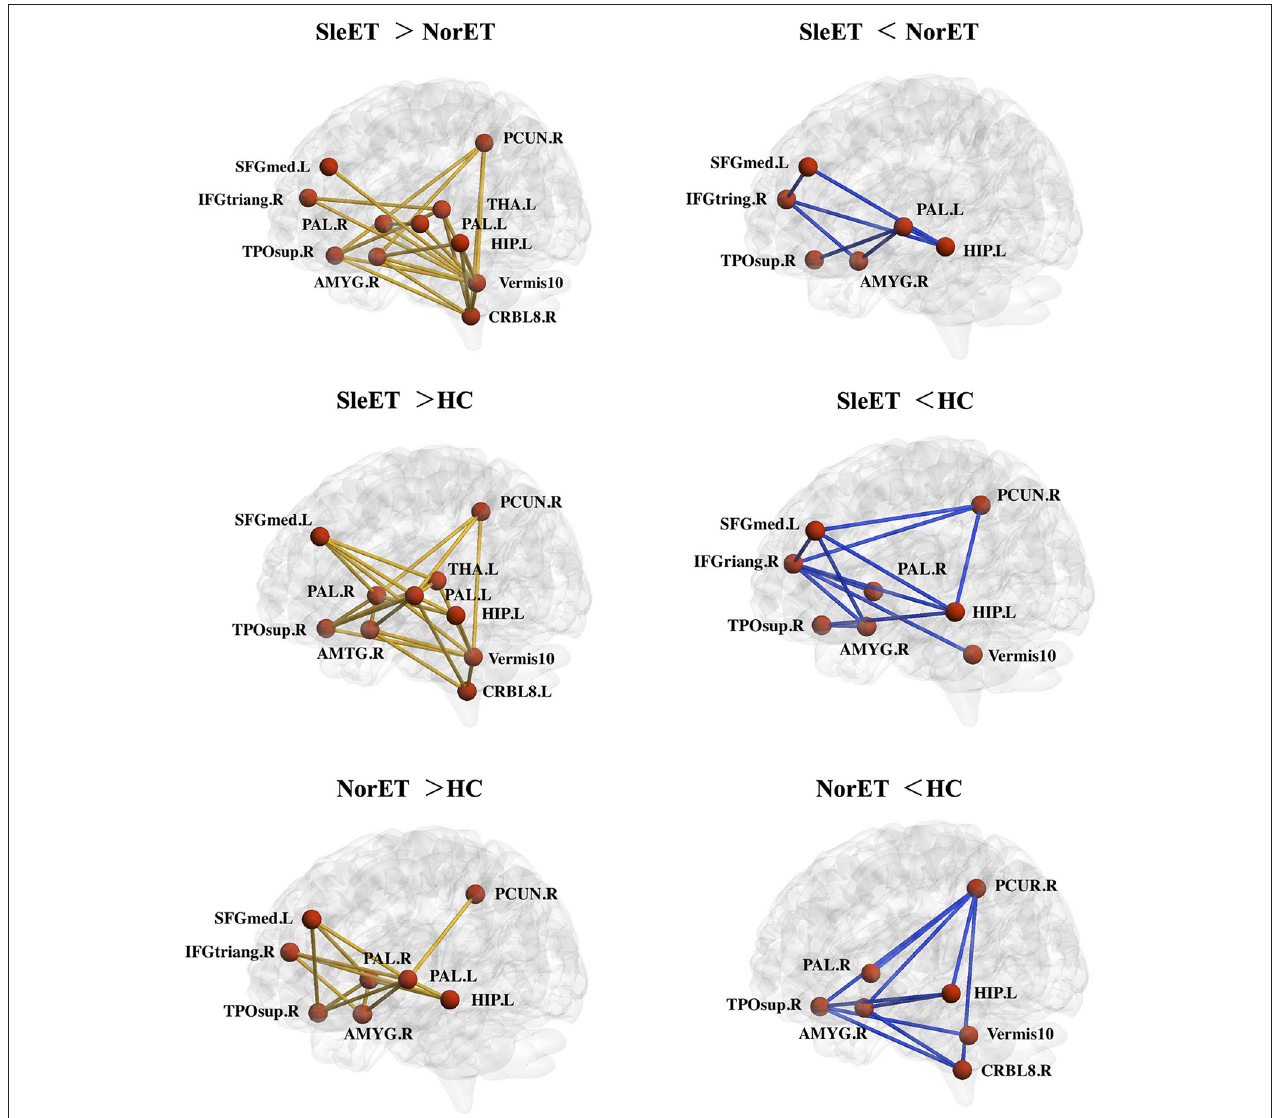
FIGURE 3 | Networks showing altered morphological connections compared among the SleET, NorET, and HC groups. Red nodes denote brain regions, and lines denote connections. Yellow/blue lines represent increased/decreased morphological connections. ET, essential tremor; SleET, ET with poor sleep quality; NorET, ET with normal sleep quality; HC, healthy control; IFGtriang, inferior frontal gyrus, triangular part; SFGmed, superior frontal gyrus, medial; PCUN, precuneus; HIP, hippocampus; AMYG, amygdala; DCG, medial cingulate and paracingulate gyri; PAL, pallidum; THA, thalamus; CRBL, cerebellum; L, left; R,